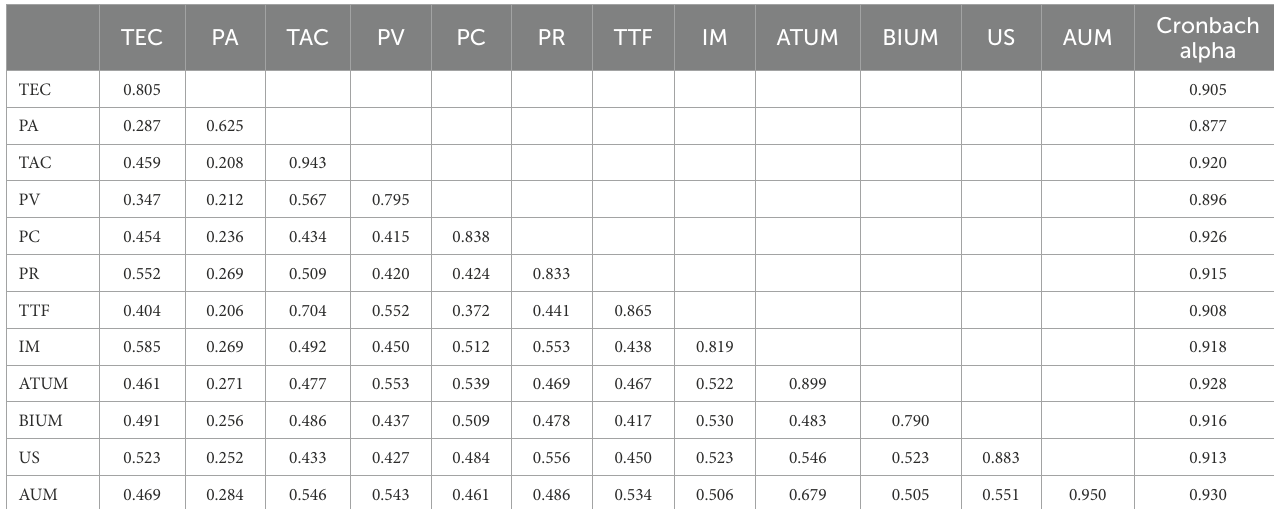
TABLE 3 Overall validity and